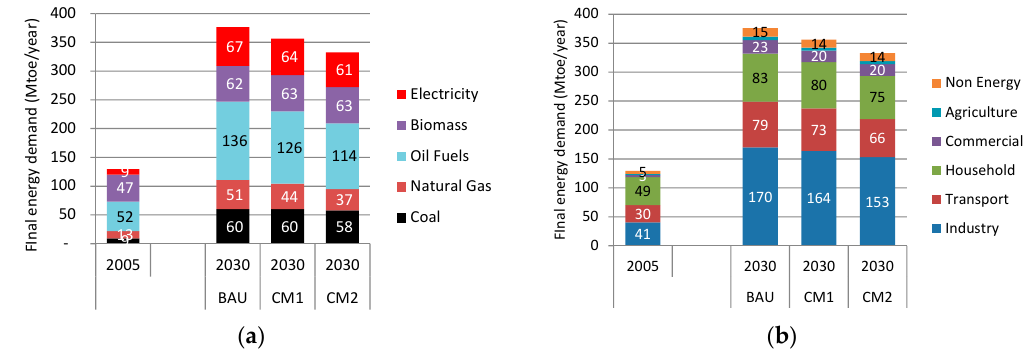
Figure 8. Reduction in total energy demands. ( a ) Reduction in total energy demands by fuel type; and